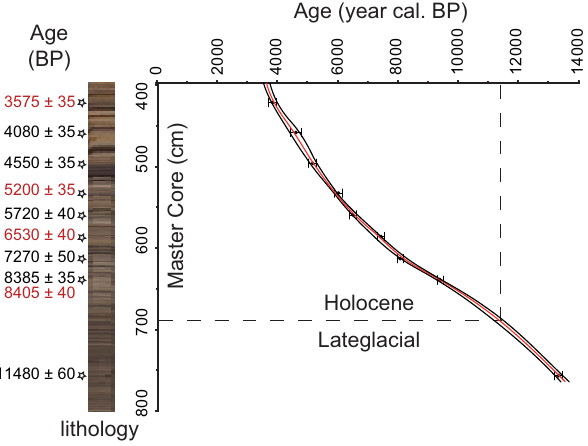
Fig. 3. Lithology of the mastercore LL081 and age–depth model based on calibrated radiocarbon ages (black dots with 2 σ errors) (AMS, see Table 1) from LL081 and LL082 (in red).